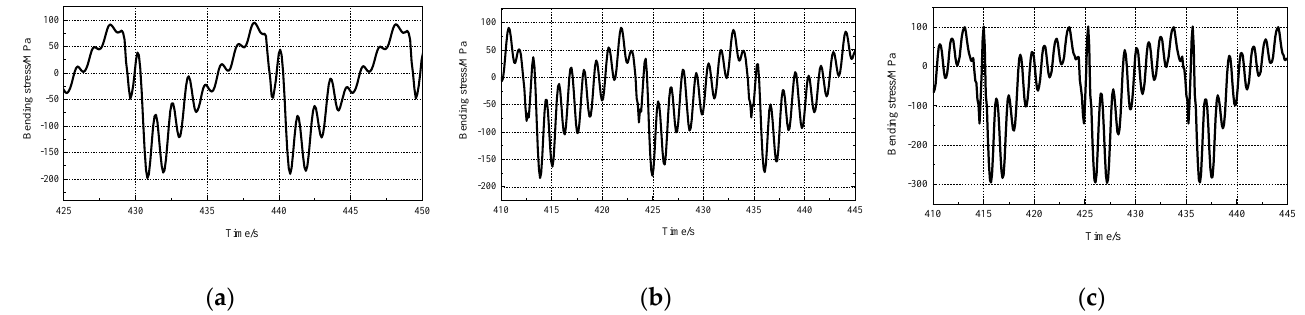
Figure 7. Time histories of deck stresses of the maximum stress section. ( a ) 5 kn; ( b ) 10 kn; ( c ) 15 kn.